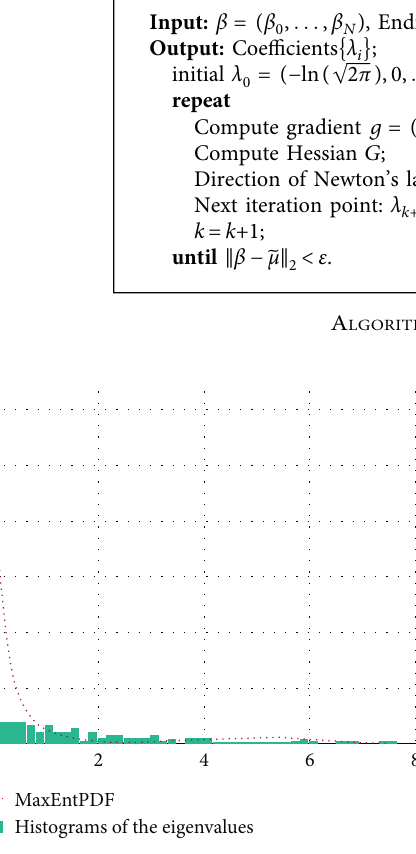
Figure 3: d � 200, n � 400, alpha � 0.5, and beta � 0.3.